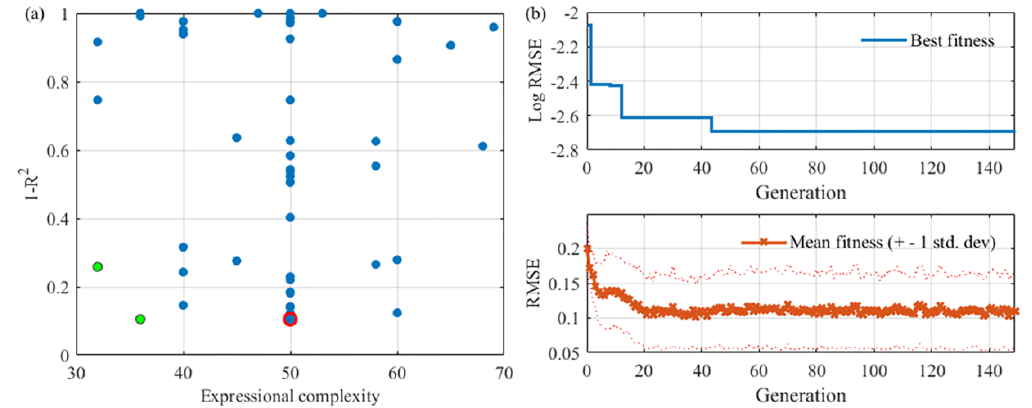
Figure 7. The Pareto front plot of the evolved SGGP-based models and convergence of the solutions: ( a ) Pareto front plot; and ( b ) convergence of the solutions.